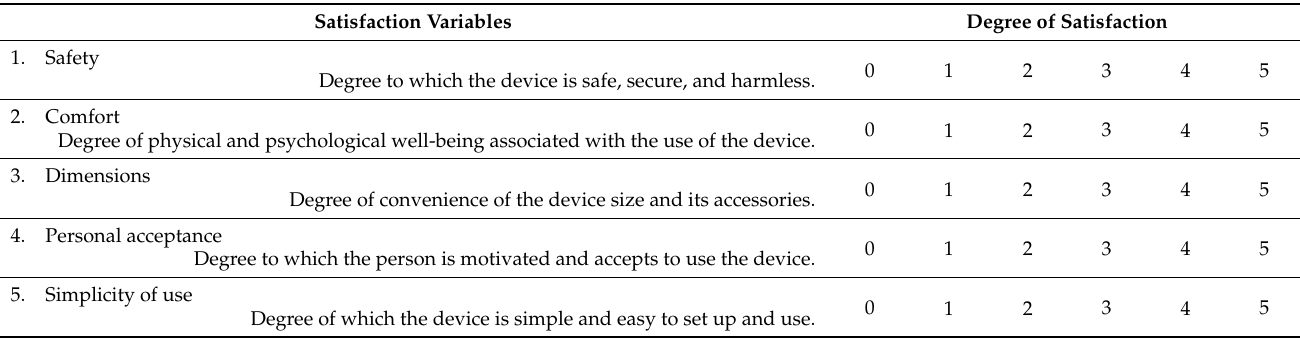
Table A1. The satisfaction